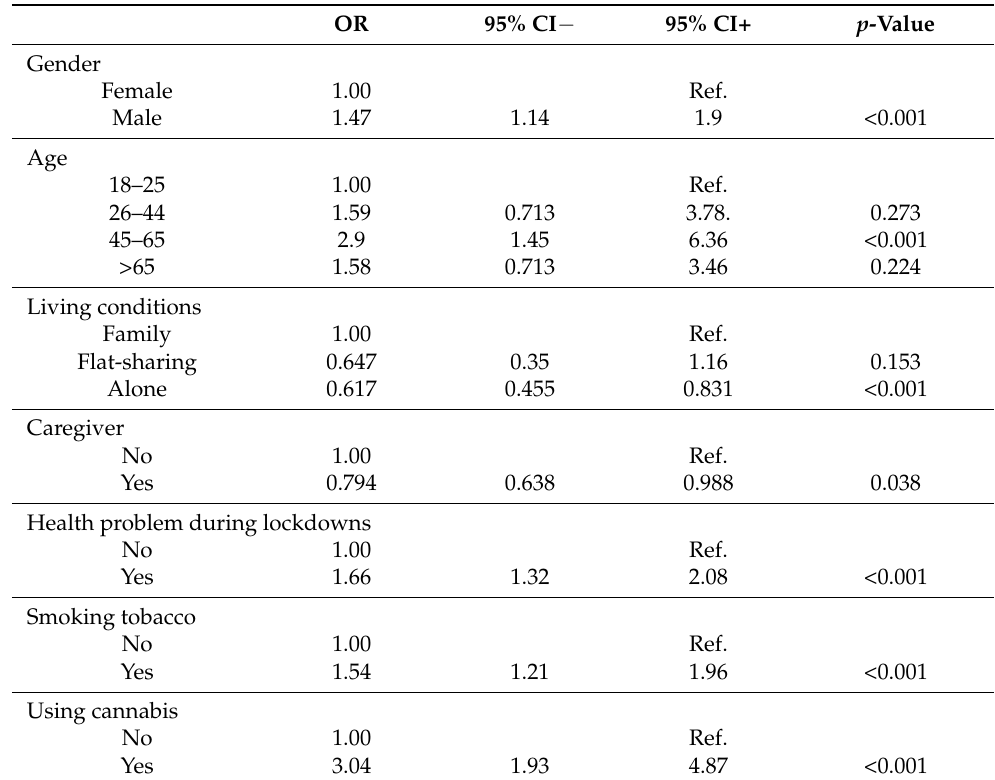
Table 2. Multivariate logistic analysis: crude and adjusted odds ratios (OR c , OR a ) and 95% confidence interval (CI) for individuals with increased alcohol consumption compared to those with stable alcohol